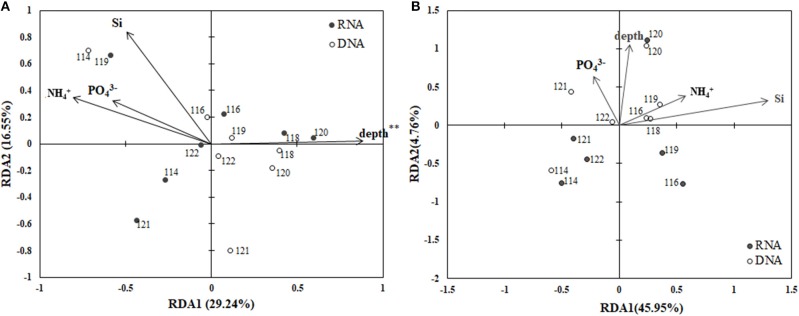
RDA ordination plots for the distributions of PA (A) and FL (B) archaeal phylogenetic groups with associated environmental parameters. **p < 0.01.